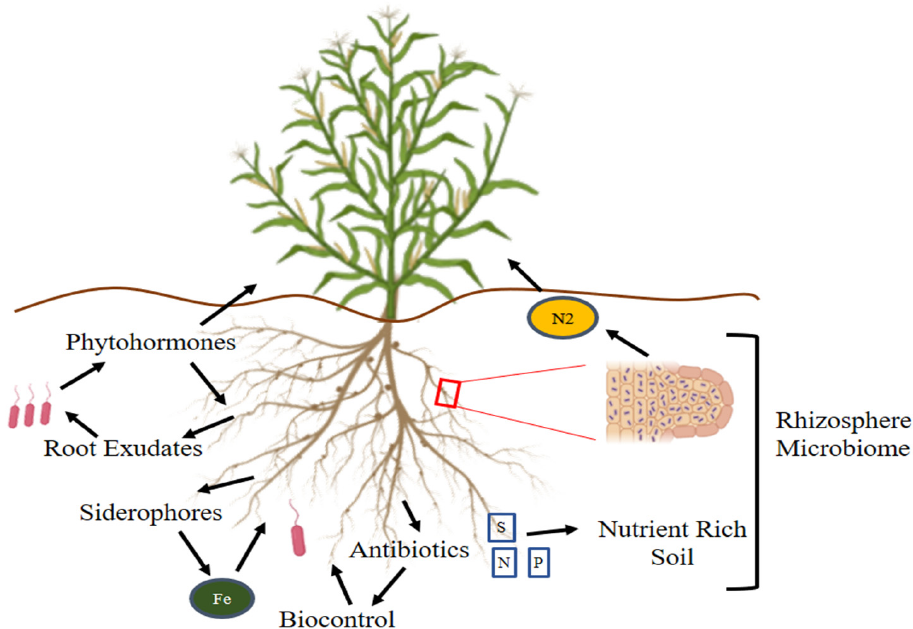
Figure 3. Strategies of PGPR for improving root architecture and overall plant growth under abiotic stresses. These microorganisms form a rhizosheath around the roots and produce antibiotics and biocontrol agents, thus protecting the roots from the adverse effects of environmental stresses.